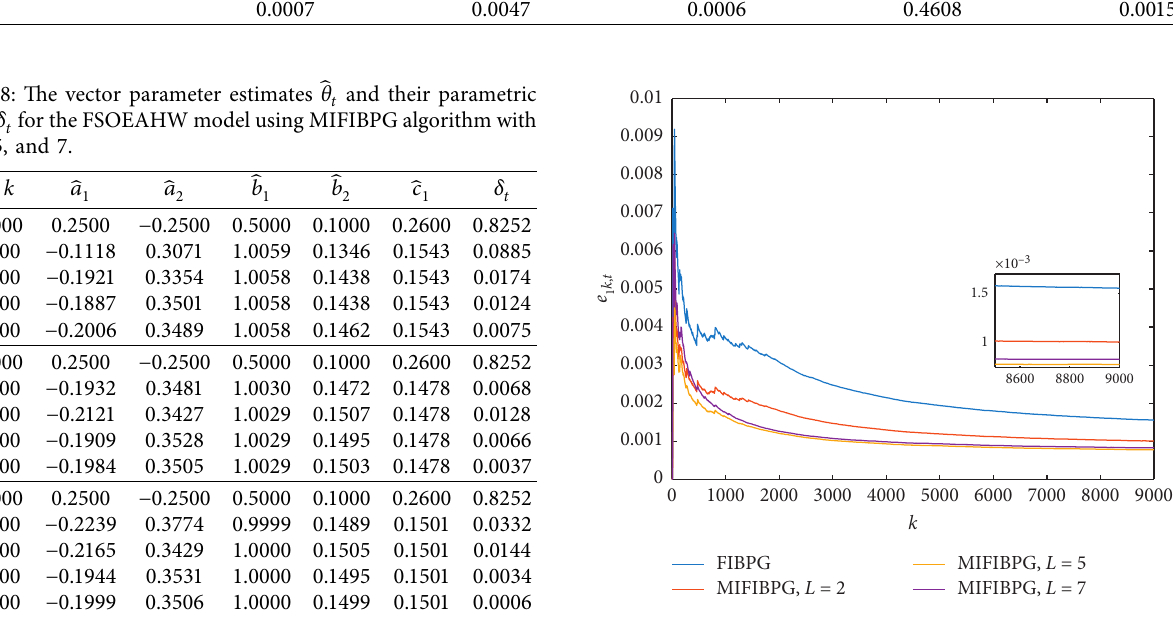
Figure 11: Evolution curves of estimation error variance for the FSOEAHW model using FIBPG algorithm.